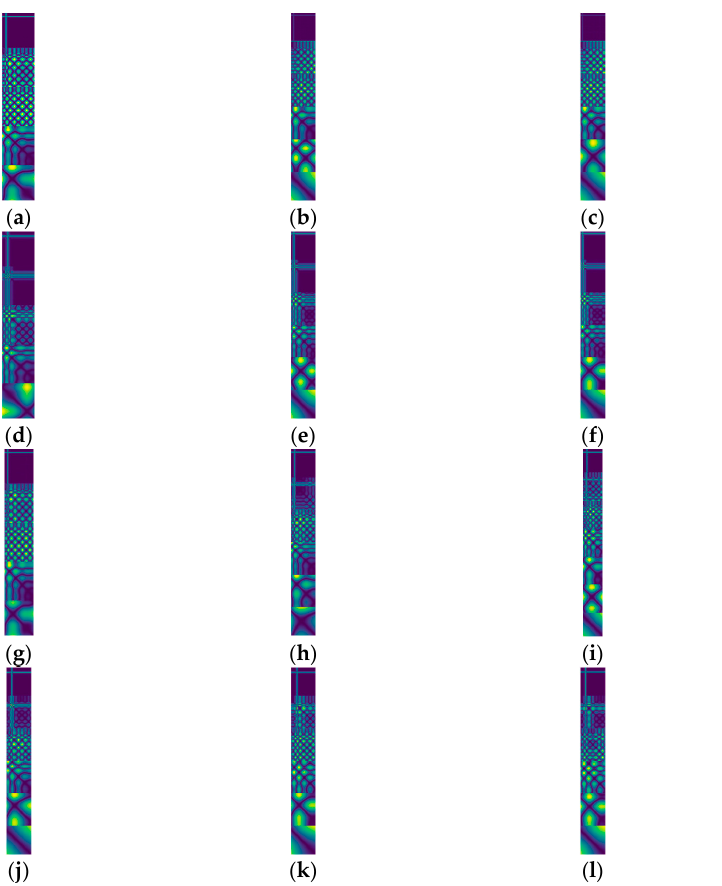
Figure 8. Generated Recurrence Plots: ( a ) grounding resistance 10 Ω ; ( b ) grounding resistance 500 Ω ; ( c ) grounding resistance 1500 Ω ; ( d ) Phase A grounded; ( e ) Phase B grounded; ( f ) Phase C grounded; ( g ) initial phase angle 0 ◦ ; ( h ) initial phase angle 60 ◦ ; ( i ) initial phase angle 120 ◦ ; ( j ) fault